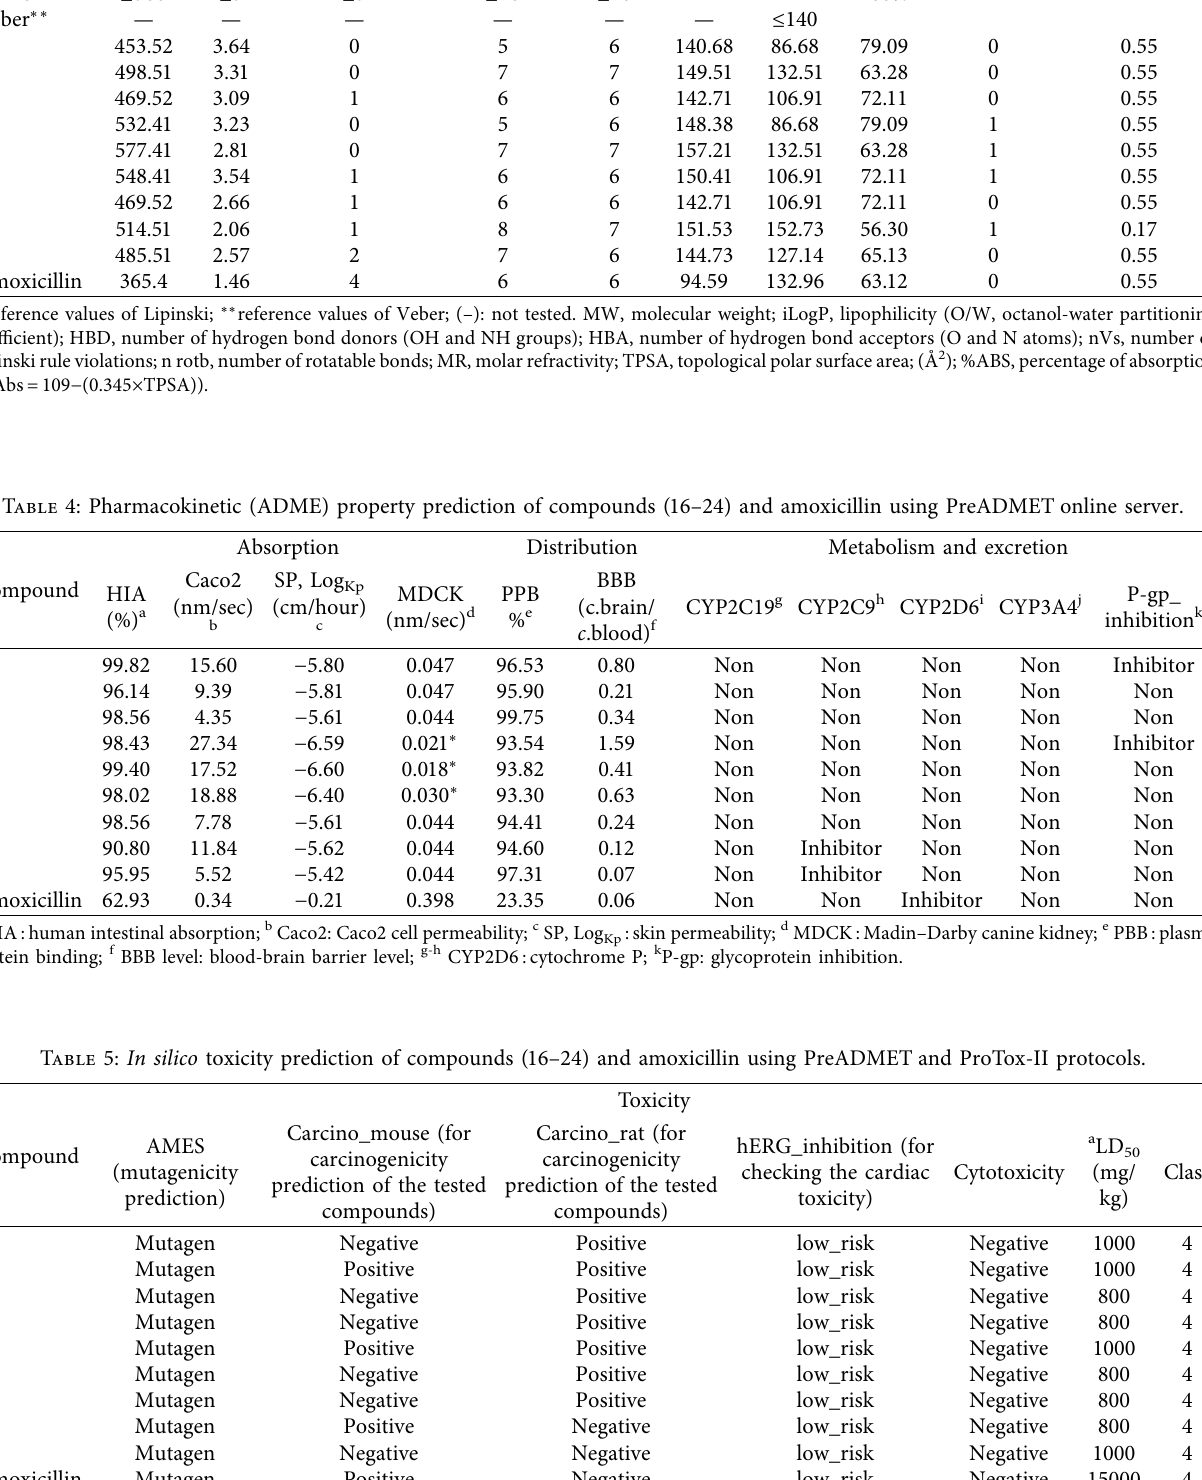
Table 3: Parameters of in silico bioavailability prediction and physicochemical properties of compounds (16–24) and amoxicillin. Compound Lipinski ∗